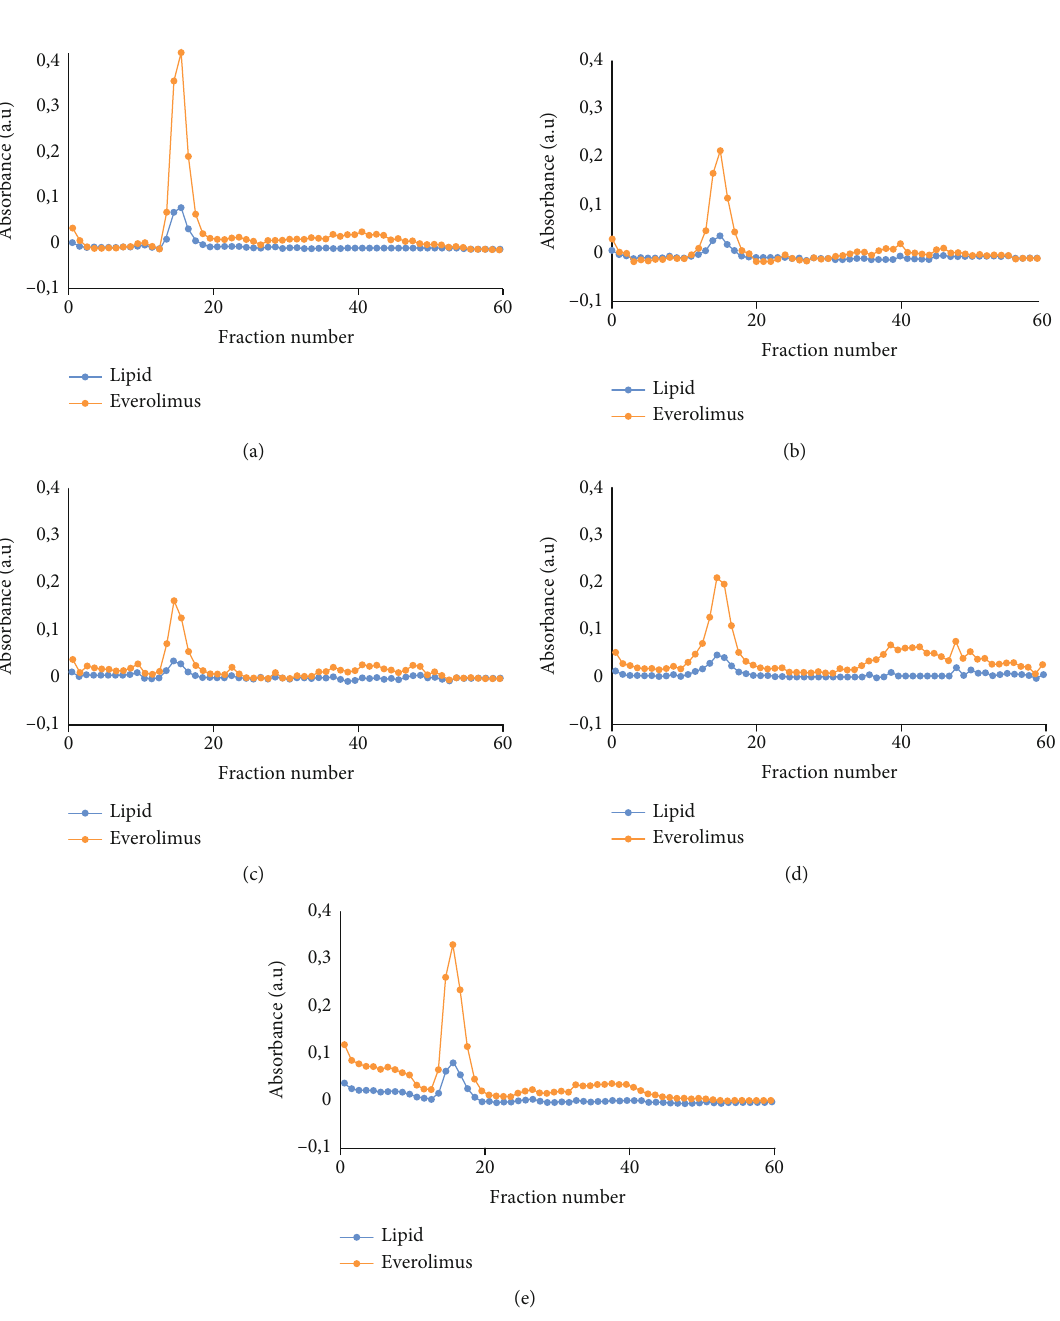
Figure 4: Entrapment analysis. UV-Vis extraction pro fi le of samples (a), (b), (c), (d), and (e) obtained from the liposomes ’ puri fi ed fractions. Table 2: Entrapment summary. Average %EE obtained by UV-Vis at 278 nm of the samples (POPC :Chol :DOPC/lipid:drug).